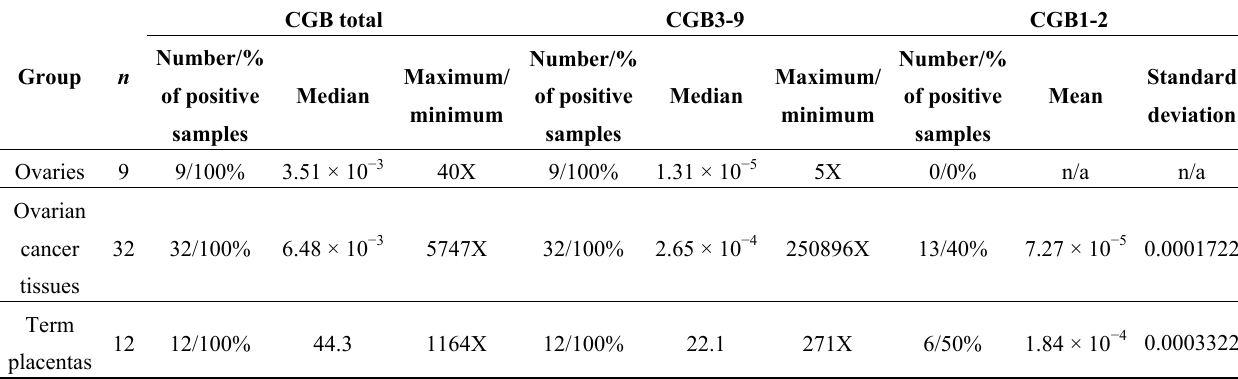
Table 1. CGB gene expression pattern within studied groups. For CGB total and CGB3-9 assays, median and extent of range (maximum divided by minimum) are presented. For CGB1-2 assay (data not normally distributed) mean and standard deviation are shown.